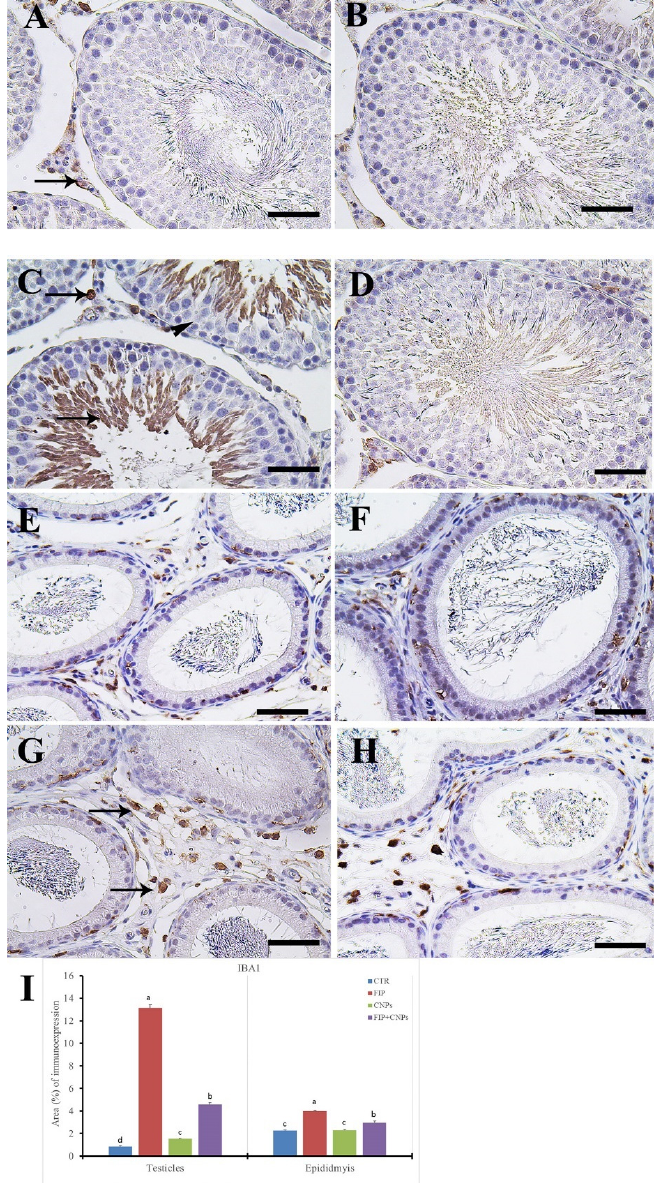
Figure 7. Immunohistochemical staining of rat testis by ionized calcium-binding adapter molecule 1 (IBA1). ( A ) Control group. ( B ) CeNPs group. ( C ) FIP group showed strong IBA1 in most sperms and interstitial tissue (arrows), while all spermatogenic cells revealed negative reactions (arrowhead). ( D ) FIP treated with CeNPs. ( E ) Epididymal of control group showing the negative IBA1 reaction in all epididymal tubules but localized moderately stained in the macrophages in the interstitial connective tissue (arrows). ( F ) CeNPs group. ( G ) FIP group showing dense strong positive IBA1 reaction in the many macrophages in the interstitial tissue (arrows). ( H ) FIP-treated with CeNPs showed low IBA1 macrophages in the interstitial tissue (arrowhead). ( I ) Semi-quantification of IBA1 in the testicular and epididymal tissues in different groups. Scale bar = 50 µm . Data expressed as Mean ± SE, analyzed using one-way ANOVA at p ≤ 0.05.